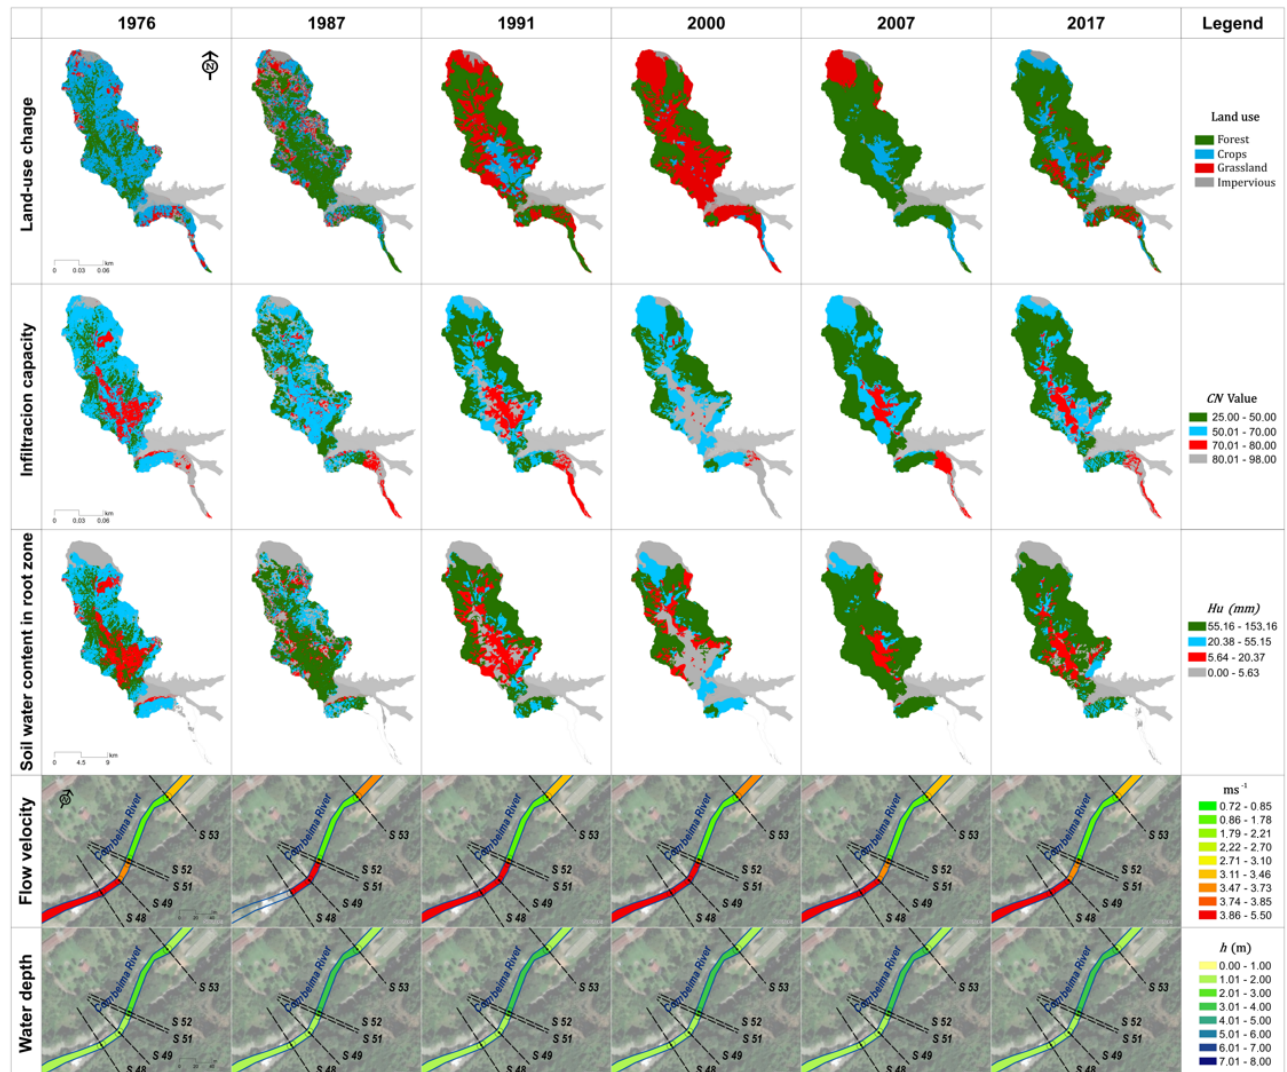
Figure 4. Simulated variations of land-use change, soil infiltration capacity ( CN ), soil water content in the root zone ( Hu ), stream flow velocity ( 𝑣 ), and water depth ( ℎ ) (in order, from top to bottom) related to land-use change during the 1976–2017 period in sections S48-S53 located in the lower part of the stream reach